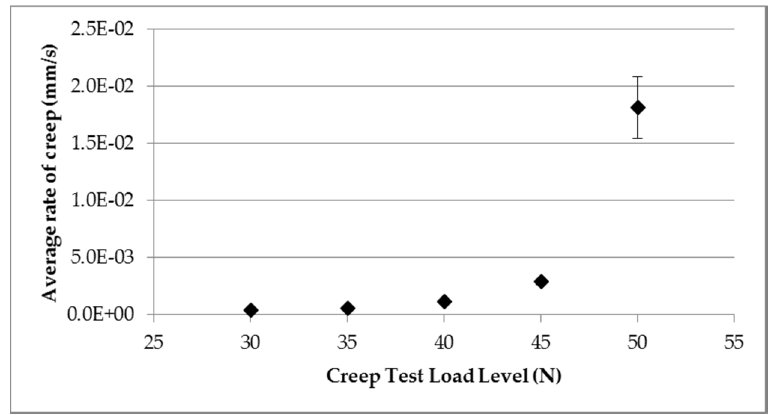
Figure 9. Average rate of creep at each load level for PMMA fibres. Three samples tested for each datapoint; error bars indicate sample standard deviation.